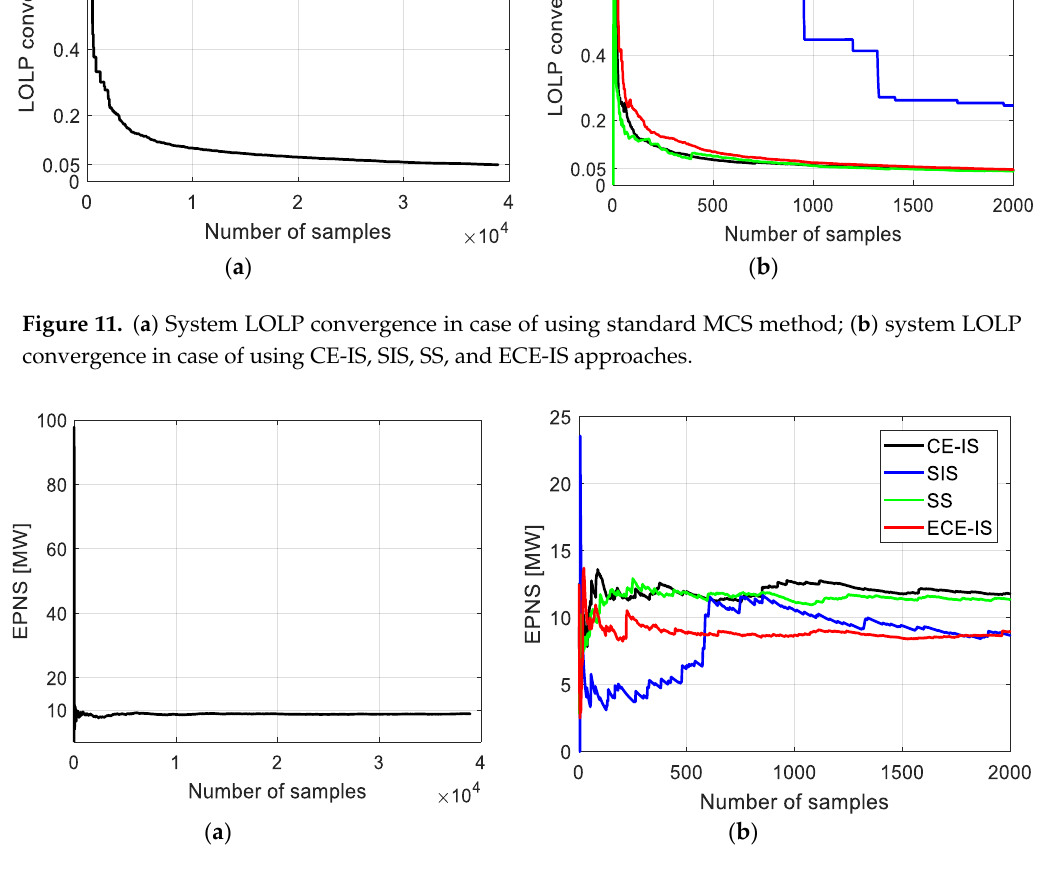
Figure 12. ( a ) System EPNS in case of using standard MCS method; ( b ) system EPNS in case of using CE-IS, SIS, SS, and ECE-IS approaches. Mathematics 2020 , 8 , x FOR PEER REVIEW